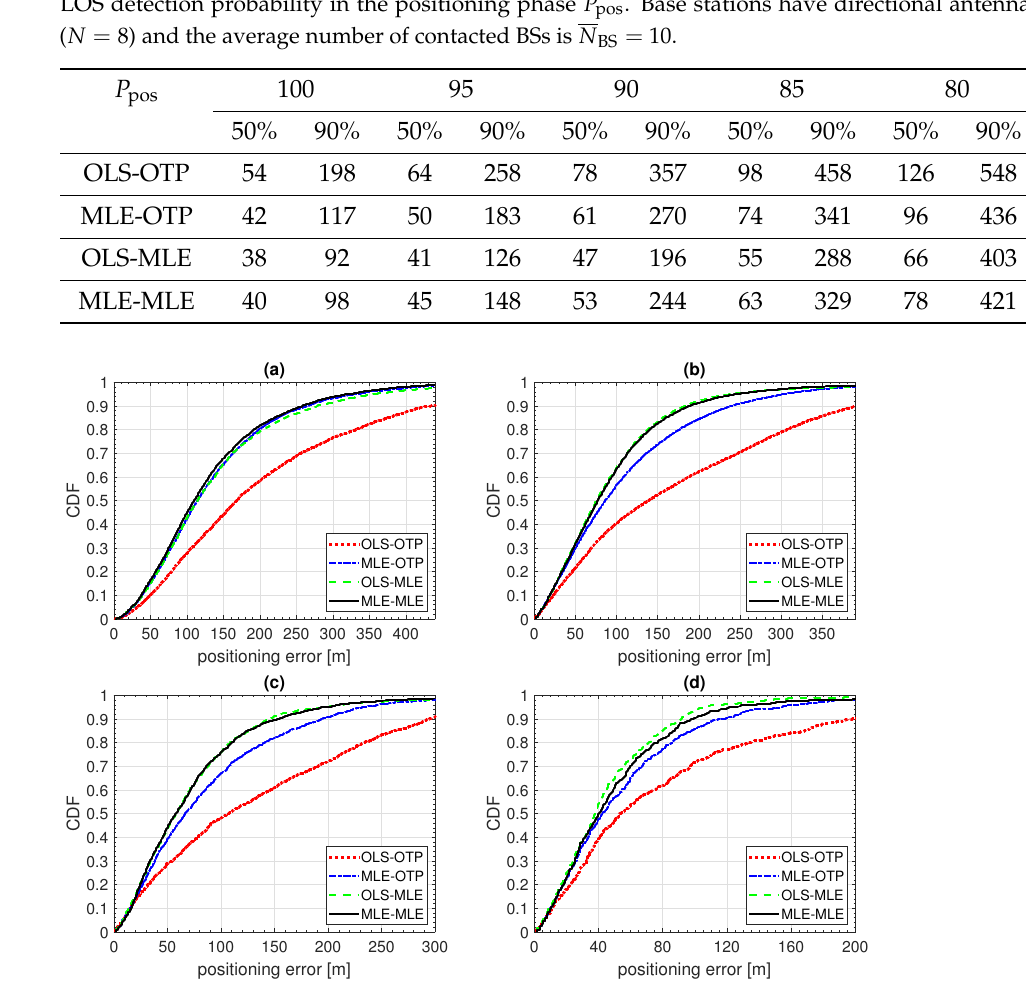
Figure 9. CDF of positioning error of Example 3. Model fitting to training data with ordinary least squares (OLS-) or Tobit MLE fitting (MLE-) and positioning with either ordinary trilateration (-OTP) of Tobit MLE positioning (-MLE). ( a ) 2 GHz, N = 1, N BS = 5, ( b ) 2 GHz, N = 8, N BS = 5, ( c ) 28 GHz, N = 8, N BS = 5, ( d ) 28 GHz, N = 8, N BS =